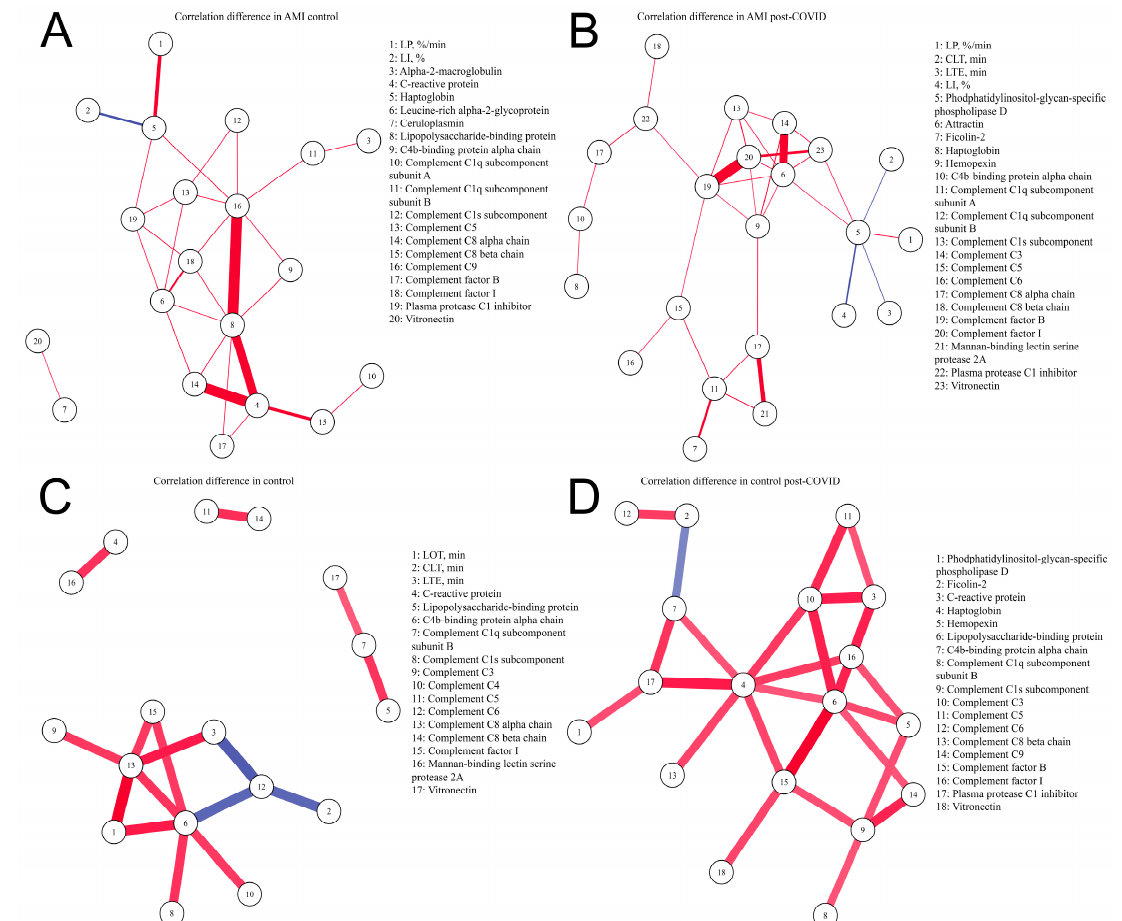
Figure 2. Differences in correlations between parameters of fibrinolysis, proteins involved in inflam- mation and components of the complement system. Differences in partial correlations were inferred on the basis of p adj. < 0.05, a magnitude of a Spearman’s correlation coefficient of at least 0.4, and a Spearman’s correlation coefficient > 0.5 or < − 0.5. In each group, we calculated the correlation coefficients between the parameters, and then compared the obtained coefficients between the groups. If there is a statistically significant correlation ( p adj. < 0.05) between the parameters in both groups, and if the correlation coefficients differ by more than 0.4, then such a correlation will be displayed in the figure between the correlating parameters. Red—positive correlation, blue—negative correlation. Line thickness depends on the Spearman’s correlation coefficient. Parameters of thrombodynamics: LOT—lysis onset time (min), LP—the rate of lysis progression (%/min), CLT—the clot lysis time (min), LI—percent of remaining clot density (%), LTE—the expected clot lysis time (min). ( A ) Correla- tions present in the AMI control group and absent in the AMI post-COVID group; ( B ) correlations present in the AMI post-COVID group and absent in the AMI control group; ( C ) correlations present in the control group and absent in the control post-COVID group; ( D ) correlations present in control post-COVID group and absent in the control